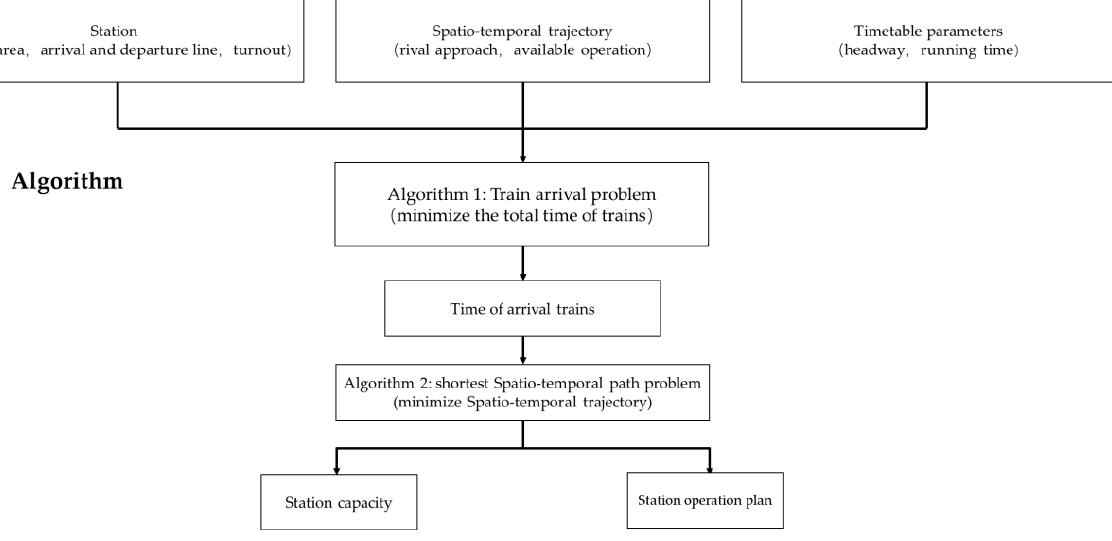
Figure 1. The framework of the station capacity methodology.